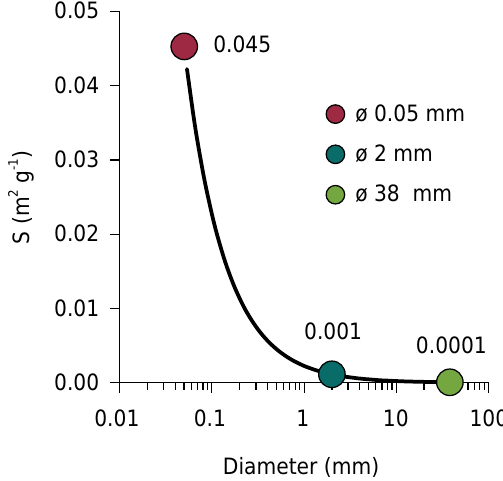
Figure 1. Specific surface area (S) of a spherical particle as a function of its diameter